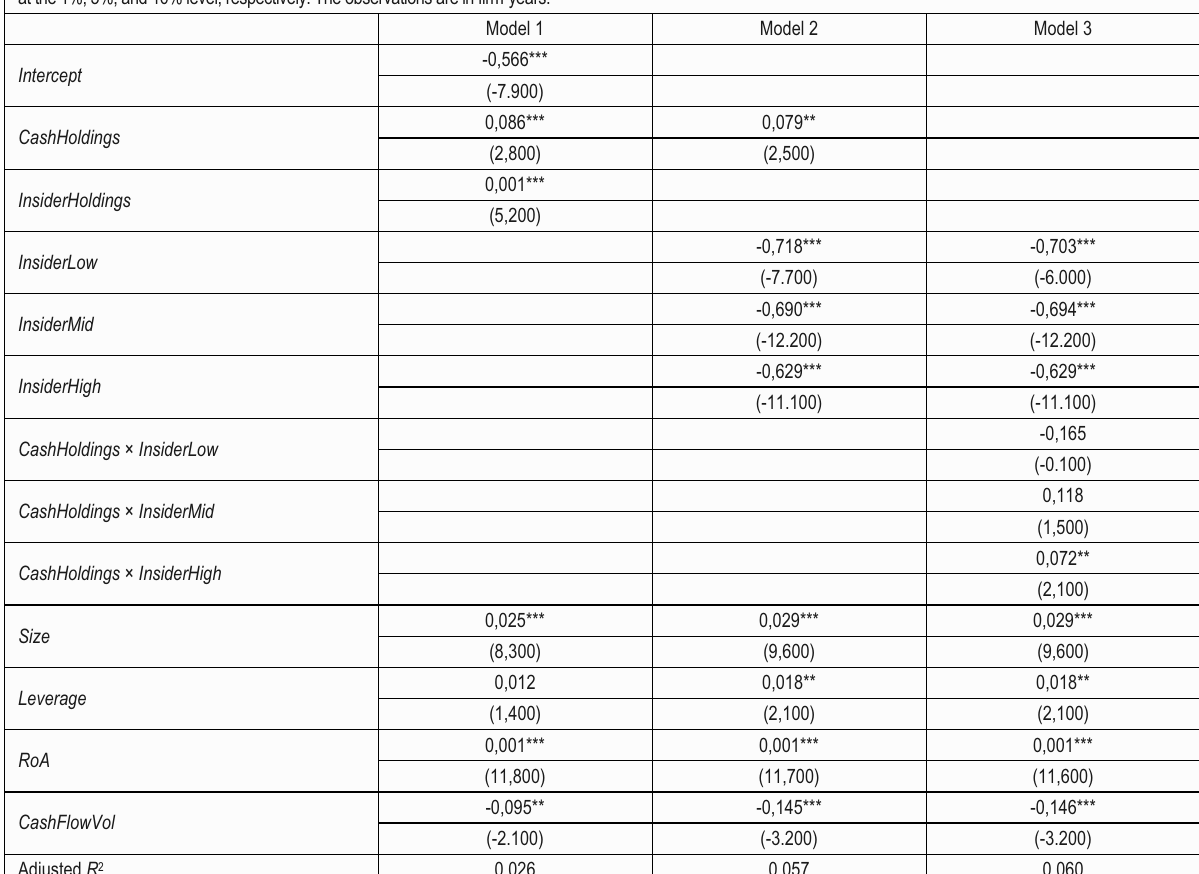
Table 7. Multivariate analysis of stock returns onto cash holdings and corporate